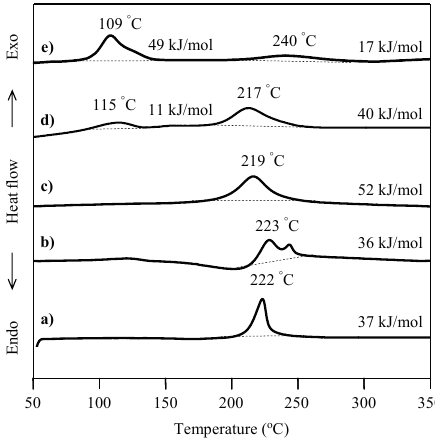
Figure 1. DSC thermograms of various BZs. P-a (a), P-a/AIBN(10 mol %) (b), P-4va (c), P-4va/AIBN (3 mol %) (d), and P-4va/AIBN (10 mol %)